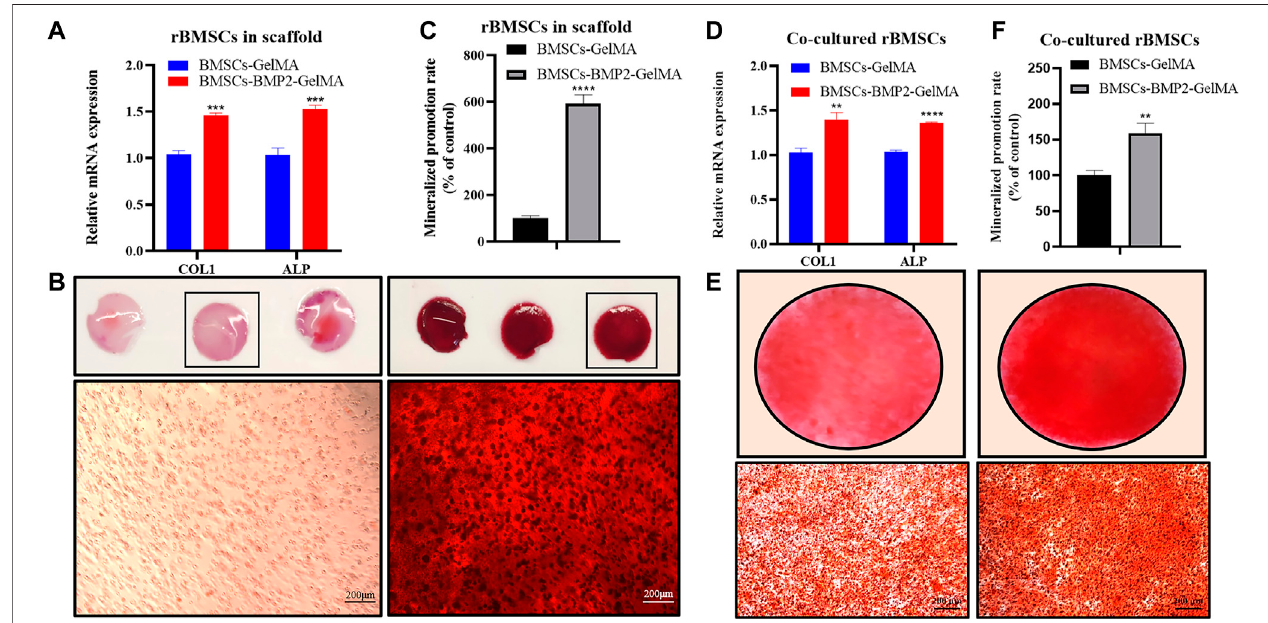
FIGURE 4 | Bioactive scaffold promoted osteogenic differentiation of BMSCs in vitro . The mRNA expression levels of COL1 and ALP of BMSCs in bioactive scaffolds (A) . The alizarin red staining of BMSCs in bioactive scaffolds (B) (bar = 200 μ m). Quantitative statistics of mineralization in bioactive scaffolds (C) . The mRNA expression levels of COL1 and ALP of BMSCs co-cultured with bioactive scaffolds (D) The alizarin red staining of BMSCs co-cultured with bioactive scaffolds (E) . Quantitative statistics of mineralization in BMSCs co-cultured with bioactive scaffolds (F) .